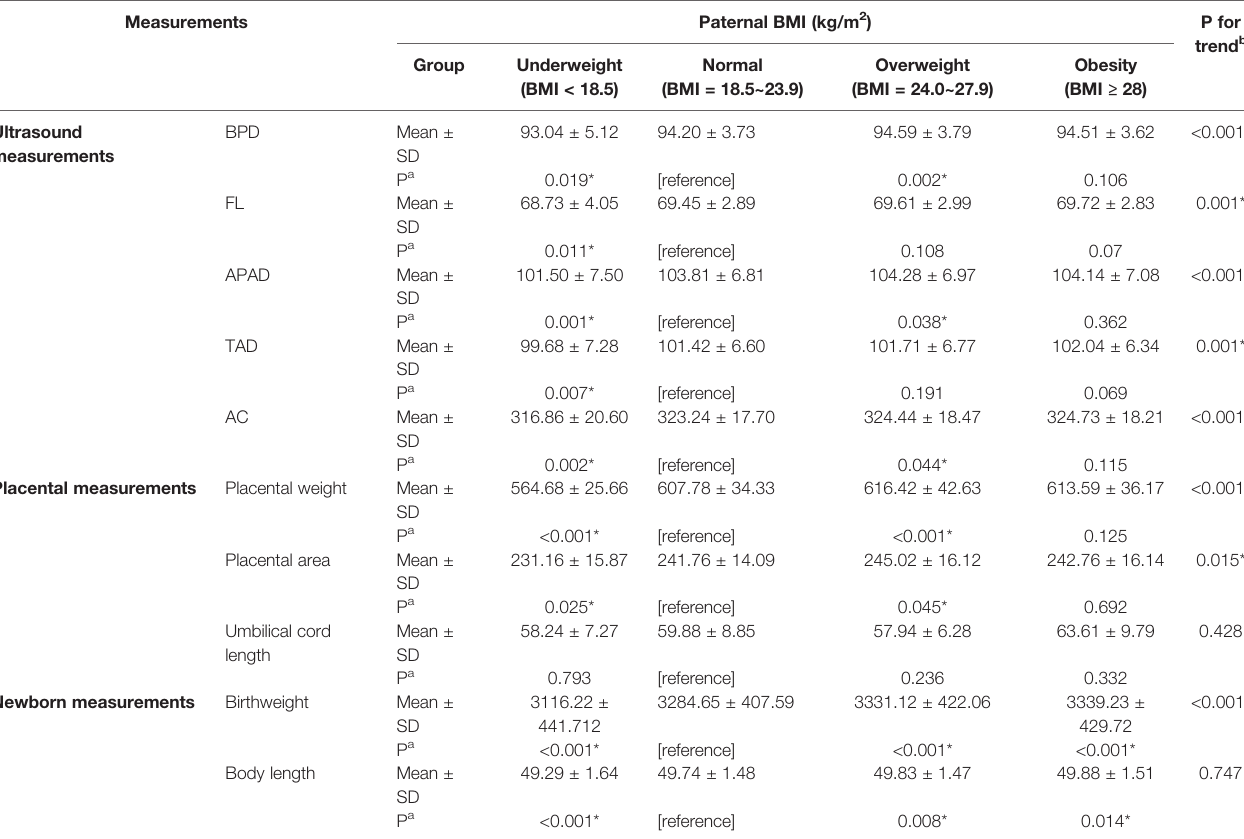
TABLE 3 | Comparison of fetal growth and placental development in different paternal BMI